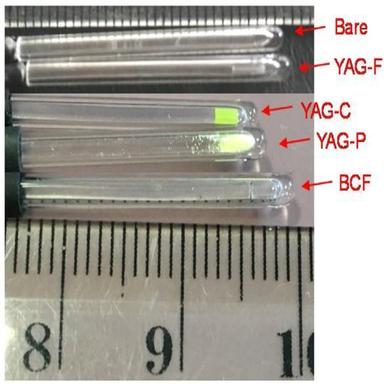
A photograph of the sensors with different scintillator materials.